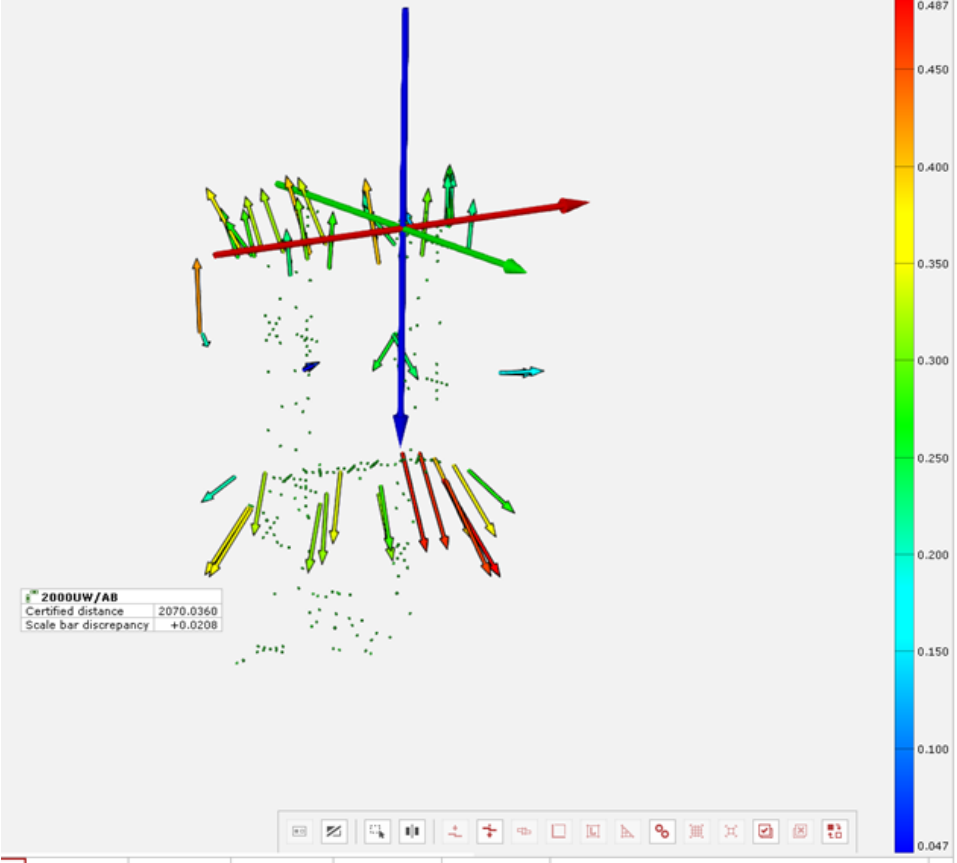
Figure 12. Displacements of measurement